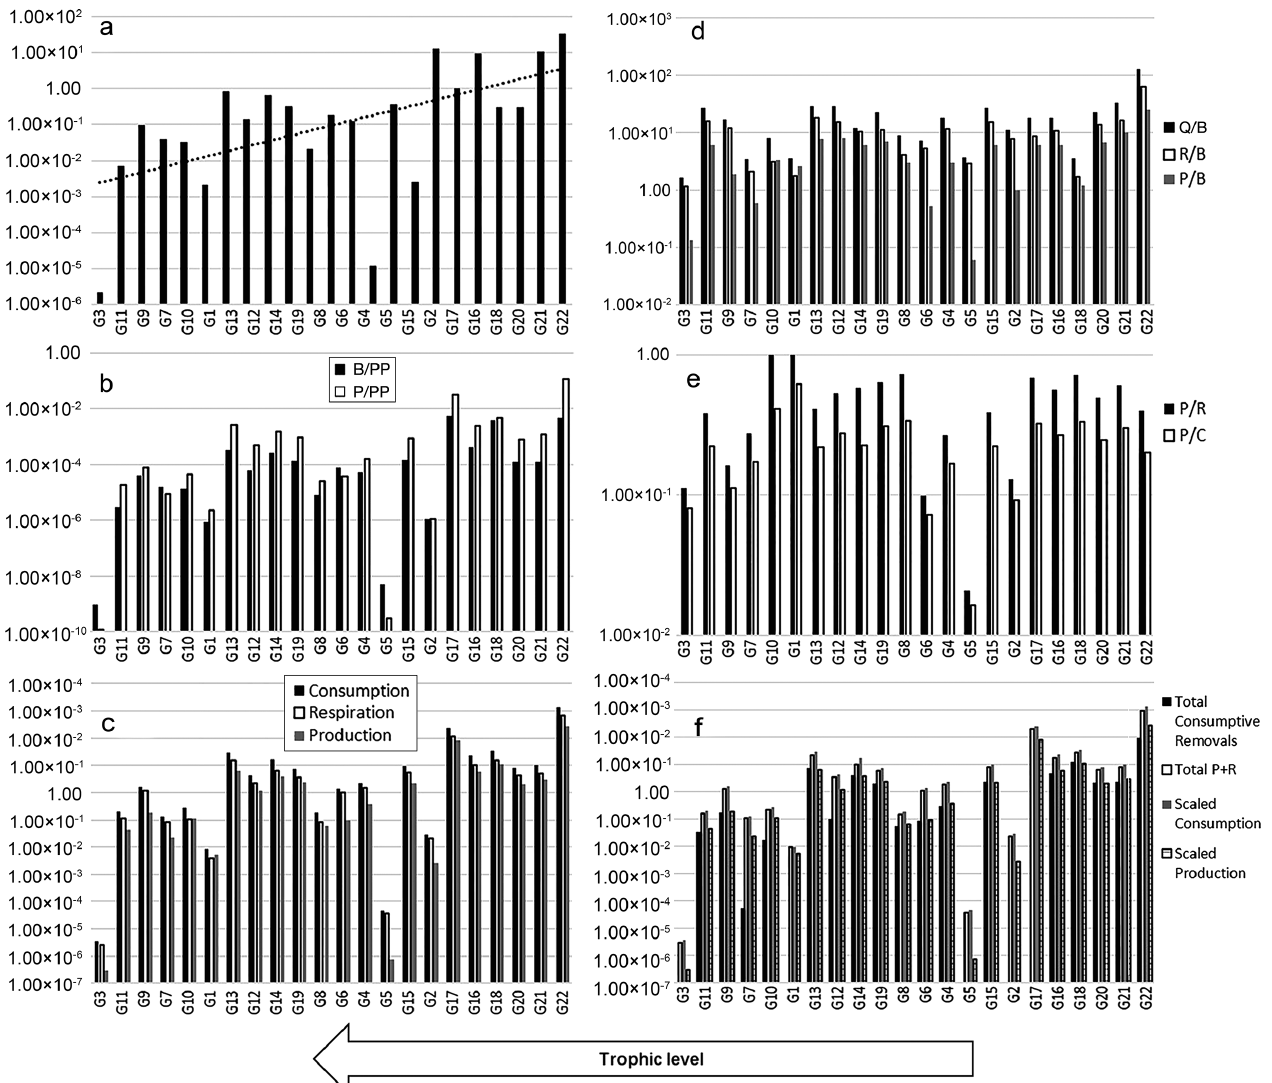
Fig. 2. Pre-balancing diagnostics on functional groups ordered by trophic level. See Table 1 for group numbers. (a) Trophic de- cline in biomass required across species groups. (b) Ratios of biomass (B) and production (P) to total primary production (PP), all required to be below 1. (c) Vital rates required to decline with trophic level, with higher consumption than production and respiration. (d) Vital rate ratios: consumption/biomass (Q/B), respiration/biomass (R/B) and production/biomass (P/B). (e) Pro- duction/consumption (P/C) required to be lower than production/respiration (P/R). (f) Total consumptive removals required to be less than production and